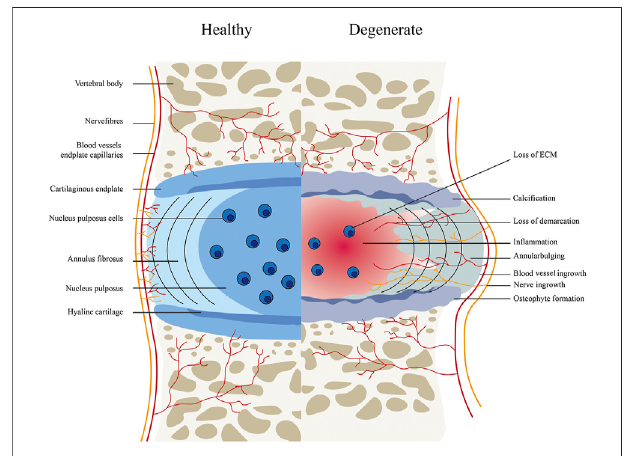
FIGURE 1 | The intervertebral disc in healthy and pathological